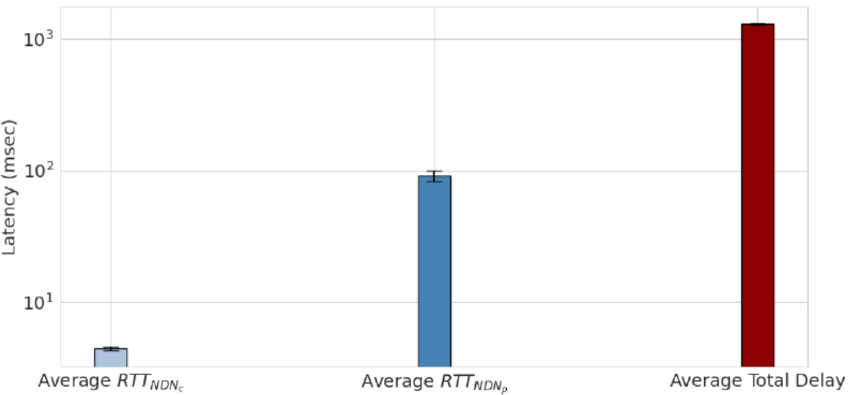
Figure 6. Average RTT NDN